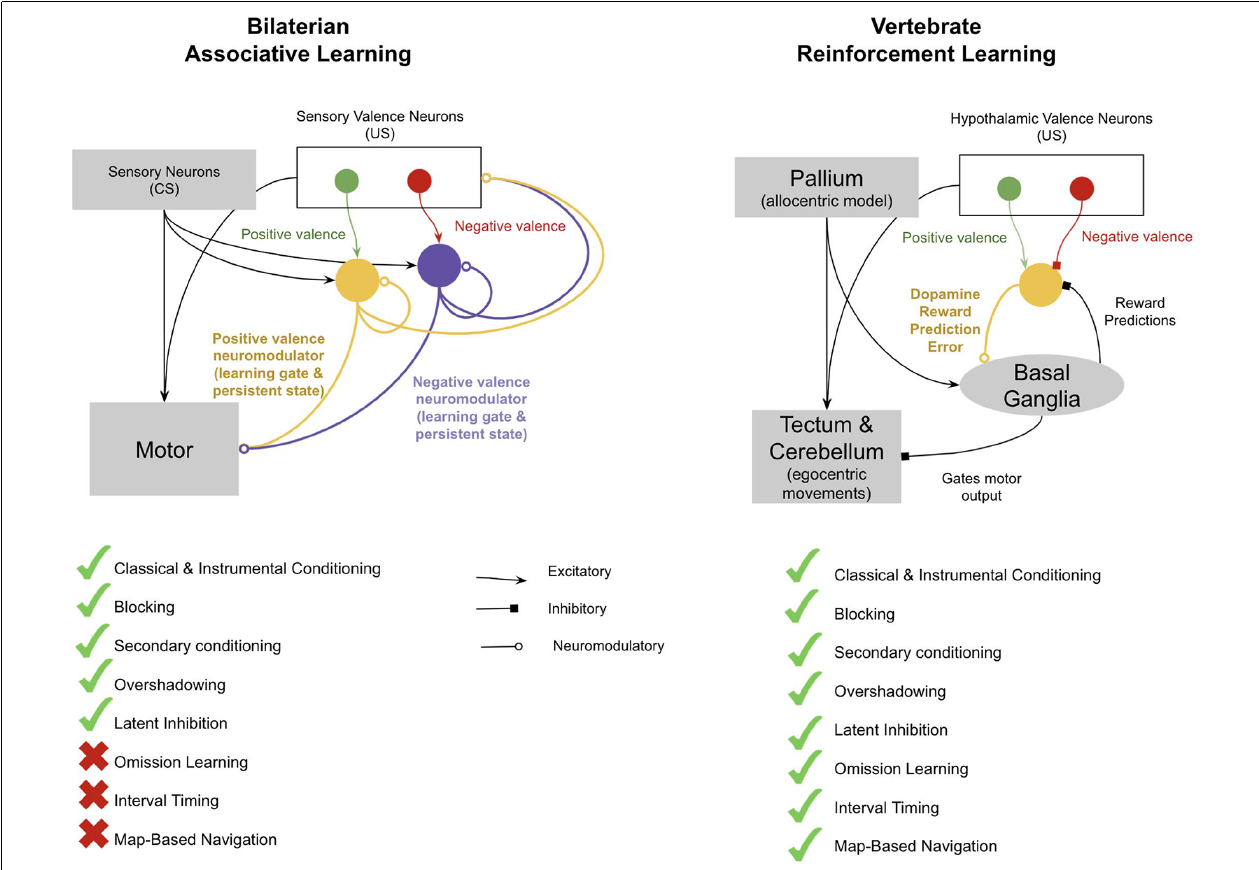
FIGURE 3 | Proposed difference between the associative learning of early bilaterians and the reinforcement learning of early vertebrates. Invertebrates implement associative learning through accommodating neuromodulators, each for different valence and reflexes. This has many of the standard features of associative learning, such as blocking, secondary conditioning, overshadowing, and latent inhibition. However, it does not enable omission learning, interval timing, or map-based navigation. In contrast, the vertebrate reinforcement learning system has all these features. Key differences include the presence of a spatial map in the pallium; timing in the cerebellum, pallium, and basal ganglia (BG); and the fact that dopamine is used to encode both positive and negative reward prediction errors. See text for more